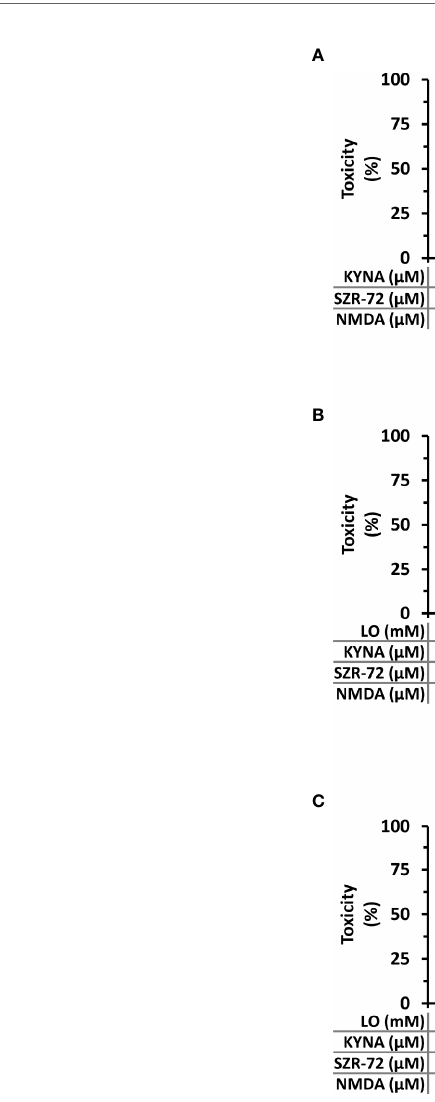
FIGURE 8 | Toxicity measurements on isolated pancreatic acinar cells. (A) Toxicity of KYNA, SZR-72, and N-methyl-D-aspartate (NMDA) in different concentrations. (B) Toxic effect of L-ornithine-HCl (LO) combined with KYNA, SZR − 72 or NMDA treatments. One-way ANOVA was performed followed by Holm-Sidak post-hoc test. Statistically signi fi cant differences (p<0.05) were marked with: (a) vs . control; (b) vs . LO; (c) vs . LO+250 µM KYNA; (d) vs . LO+2500 µM KYNA; (e) vs . LO+250 µM SZR- 72. (C) Toxicity of co-treatment of LO (20 µM) and NMDA (25, 250, 2500 µM) combined with 250 µM KYNA or SZR-72. One-way ANOVA was performed followed by Holm-Sidak post-hoc test. Statistically signi fi cant differences (p<0.05) were marked with: (a) vs . control; (b) vs . LO; (c) vs . LO+250 µM KYNA+25 µM NMDA; (d) vs . LO+250 µM KYNA+250 µM NMDA. Values represent means with standard error,